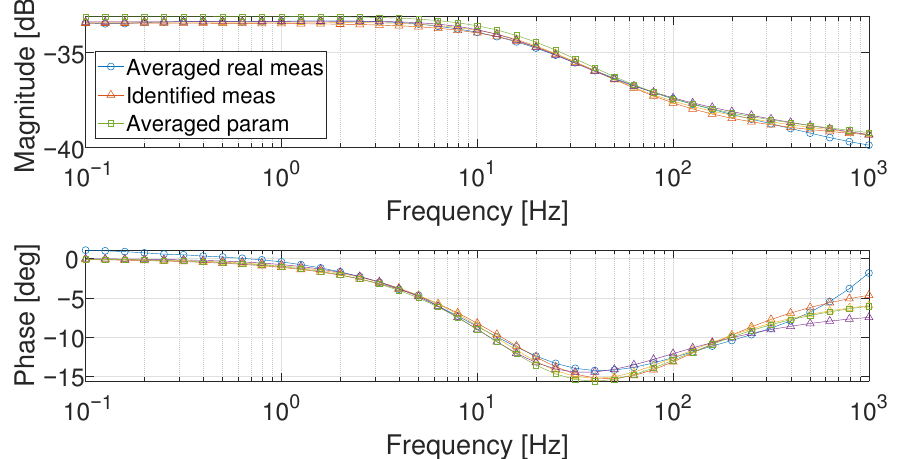
Figure 16. Comparison of the Bode diagrams obtained with the real averaged measurement (circle marker), the model obtained on a single measurement (triangle markers, three curves), and that obtained with the averaged parameters (square marker) at